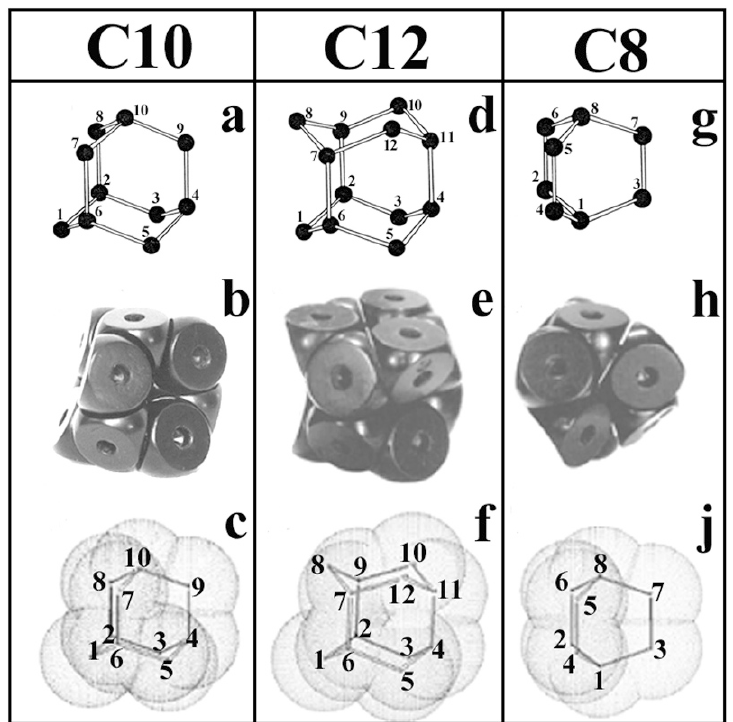
Figure 1. Potential building units of diamond. The adamantane analog C10 unit of cubic diamond contains three cyclohexane rings all in chair conformation; C12 unit: two chairs surrounded by three boats; C8 unit: three rings all in boat conformation. a,d,g: ball and stick models; b,e,h: space filling models; c,f,j: computer generated models (ChemDraw Ultra